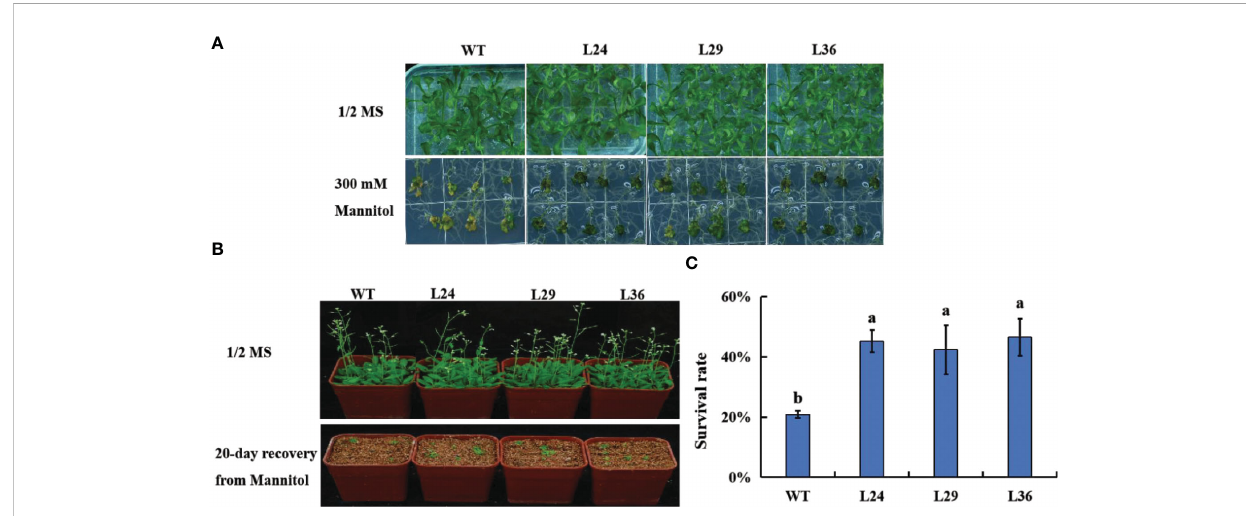
FIGURE 7 The effect of GhGT23 overexpression on Arabidopsis in response to drought-simulating mannitol treatment. (A) Images of WT and transgenic Arabidopsis plants overexpressing GhGT23 (L24, L29, and L36) 12-days after being transferred to 1/2 MS agar with and without 300 mM mannitol. (B) Images of WT and transgenic Arabidopsis plants treated with 300 mM mannitol, followed by a 20-day recovery period in vermiculite. (C) Survival rates of WT and transgenic plants after a 20-day recovery period from mannitol treatment. Each bar represents the average of three experiments with 36 plants used in each experiment. Error bars indicate standard deviation and different letters indicate signi fi cant differences (p < 0.05), which were determined using ANOVA, followed by Duncan ’ s multiple comparison test.